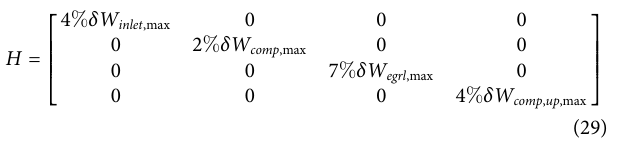
selection algorithm (per Section 2 ) for different sensor